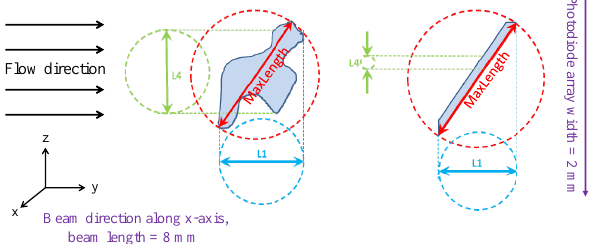
Figure A1. Geometry of dimension measurements showing length scales for the M1 method (L1) and the M7 method (MaxLength) for two different ice particle shapes. Courtesy of Paul Lawson and Sara